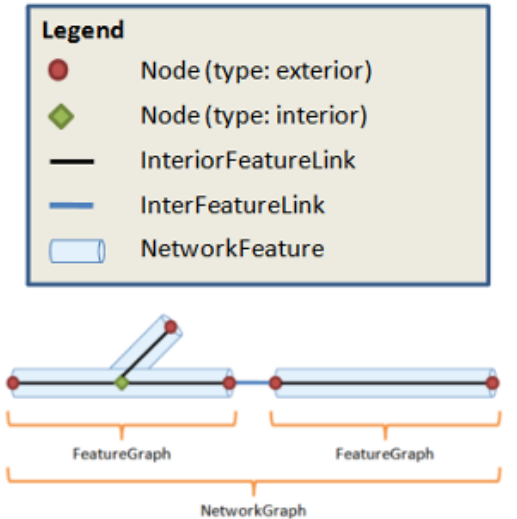
Figure 2. The “NetworkFeature” elements represent the physical